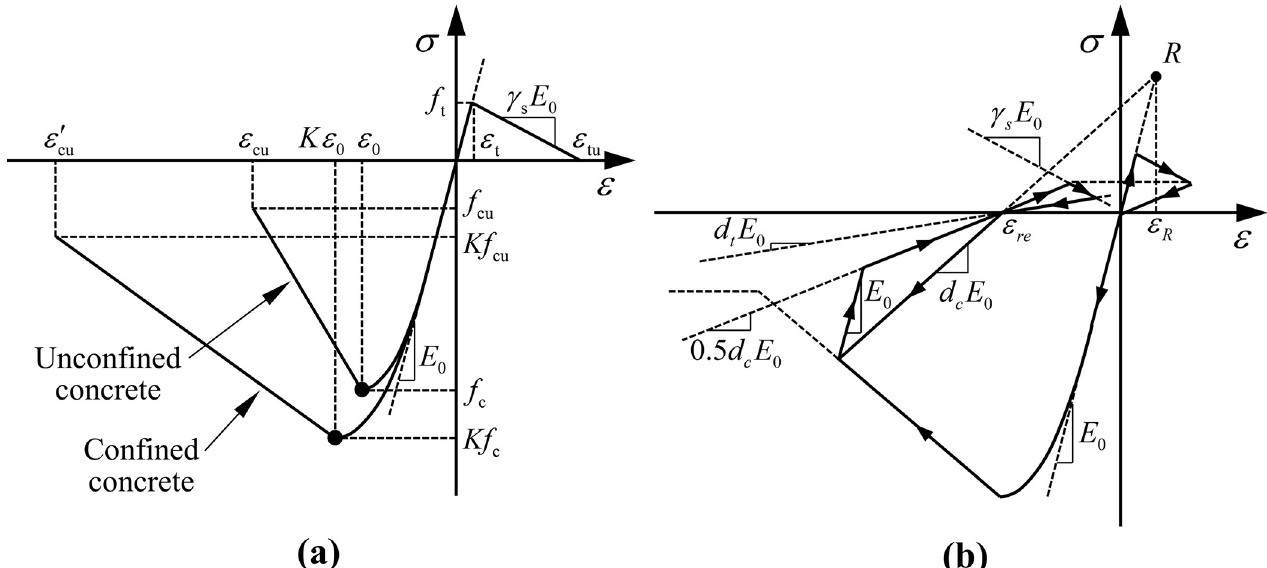
Fig 3. Uniaxial constitutive model for concrete. (a) Stress-strain envelope curve, (b) Loading-unloading criteria.